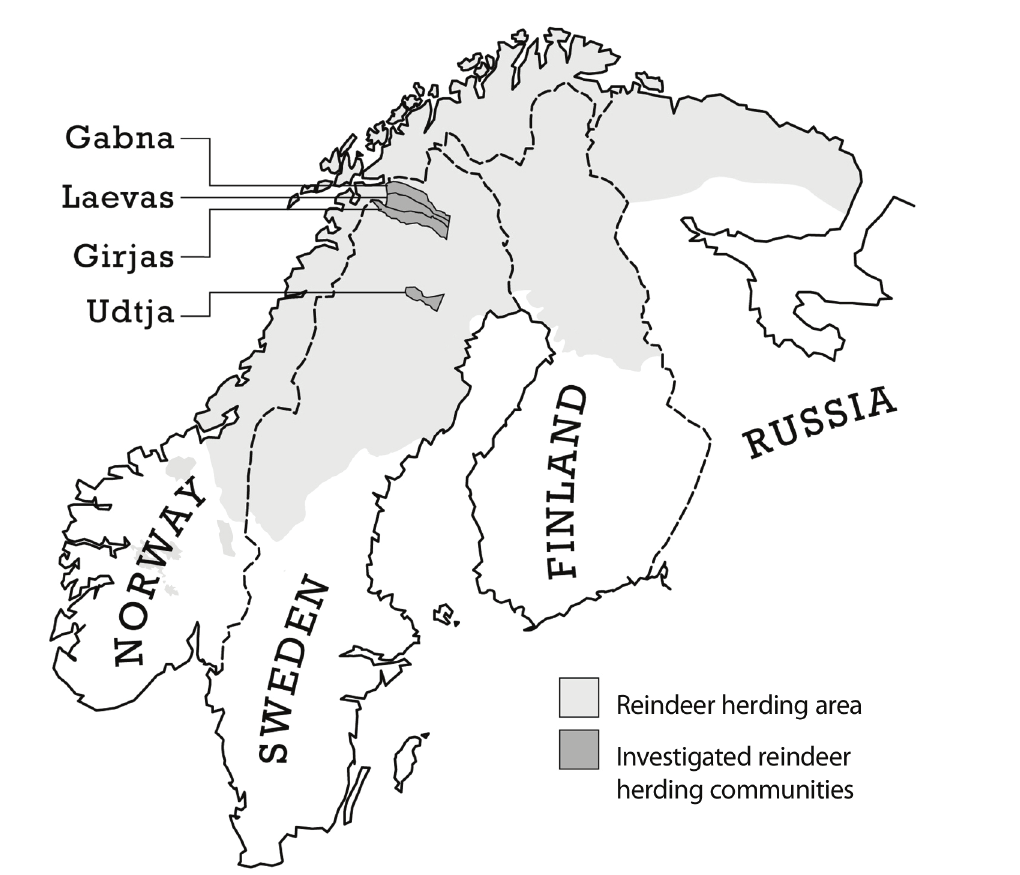
Fig. 1. Summer grazing areas of the four Sami reindeer herding communities included in the study. The map is based on information from Renbeteskommissionen, svensk - norska (2001), Kemppainen et al . (1997). Drawing: Jon Mihkkal